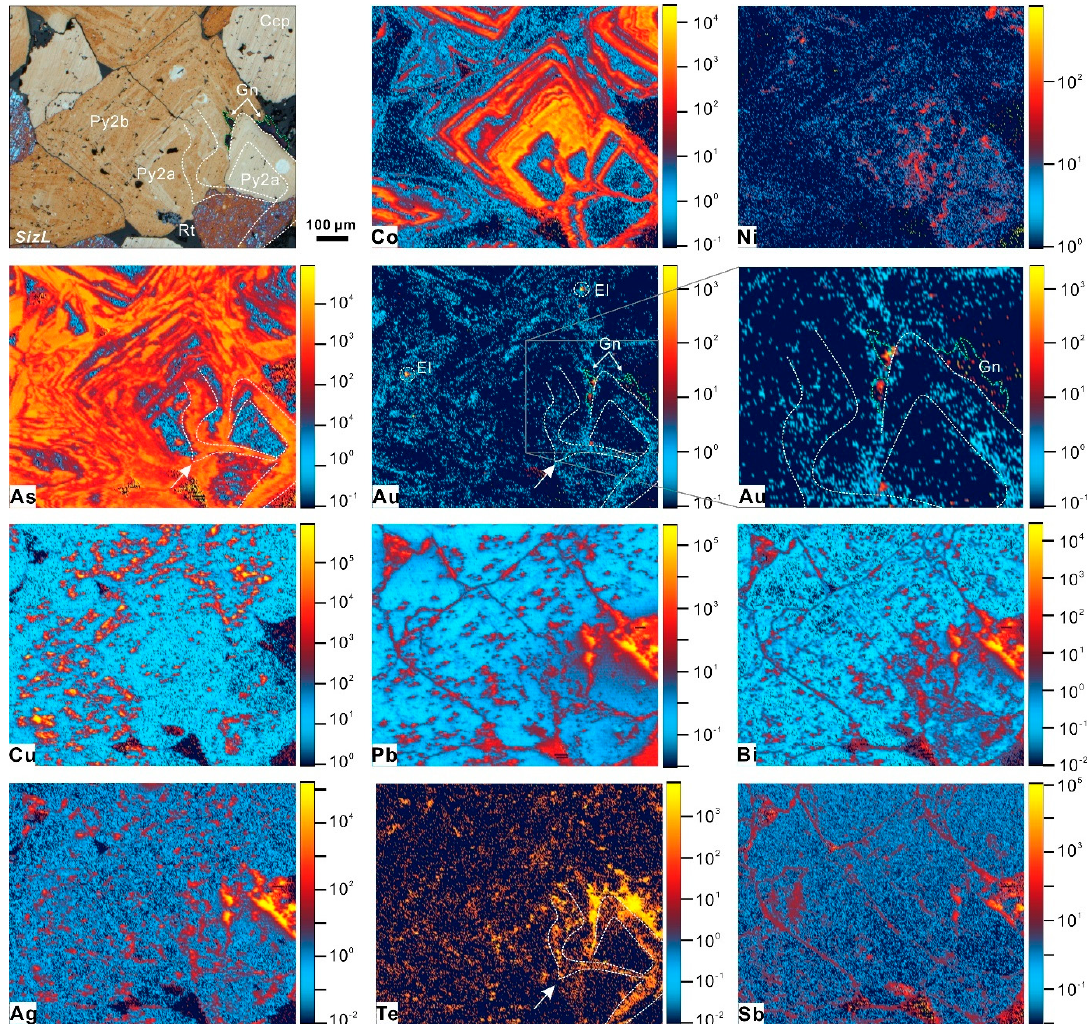
Figure 10. Reflected-light and LA–ICP–MS mapping images of representative NaClO-etched Py2 grains from the sample SizL illustrating the general variation of trace elements (in ppm). Early-phase Py2b is Co-rich relative to late-phase Py2b that is enriched in As and Au. Note high Au and Te concentrations occur in the local high-As areas in Py2b (marked by arrows and white dashed line). Galena grains (green dashed line) are relatively enriched in Bi, Au, Ag, Sb, and Te. Note there is much fine-grained gold within the galena.